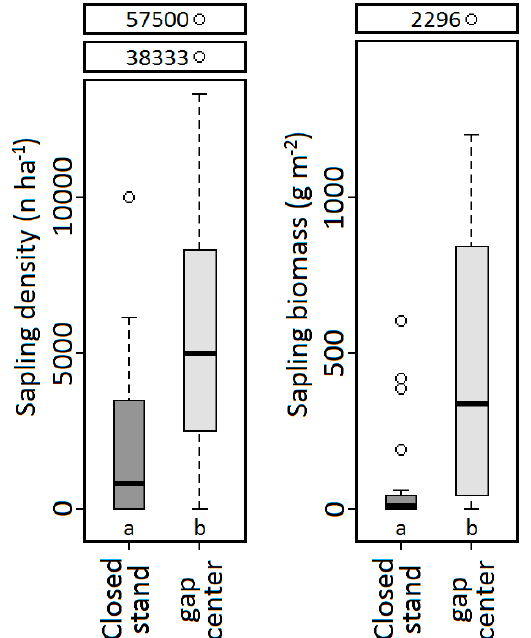
Figure 2. Density of saplings ( ≥ 0.5 m) and estimated cumulative sapling biomass in closed-canopy and gap plots (only gaps with regeneration layer < 3 m height at the time of gap formation). Box-whisker plots with median (thick black line), 25-and 75-percentiles (box) and extremes not exceeding the 1.5fold of the interquartile range (whiskers). Dots mark extreme data points beyond 1.5 times the IQR. N = 17 plots in gaps and 32 plots under closed canopy. The dashed grey line marks the median values of samples containing 48 plots á 13 m 2 selected by random in the forest (including gap and closed-canopy plots). Different letters below the boxes indicate significant differences between the groups (Wilcoxon rank-sum test).